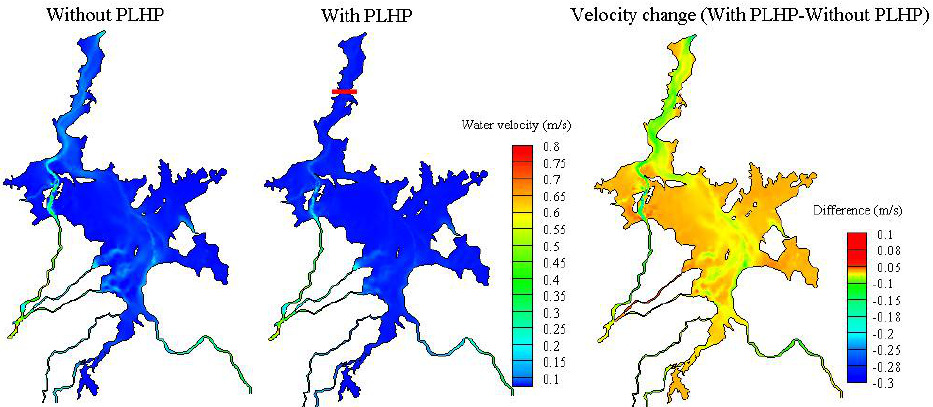
Figure 7. Influence of the PLHP on spatial water velocities averaged over the storage period of the PLHP. Positive differences indicate that the water velocity in the scenario with PLHP is higher than the natural condition.